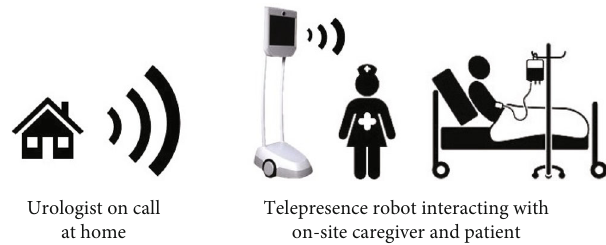
Figure 2: Communication via the telepresence robot. Using the telepresence robot, the urologists can move around and interact with patients and on-site caregivers with audio and video.